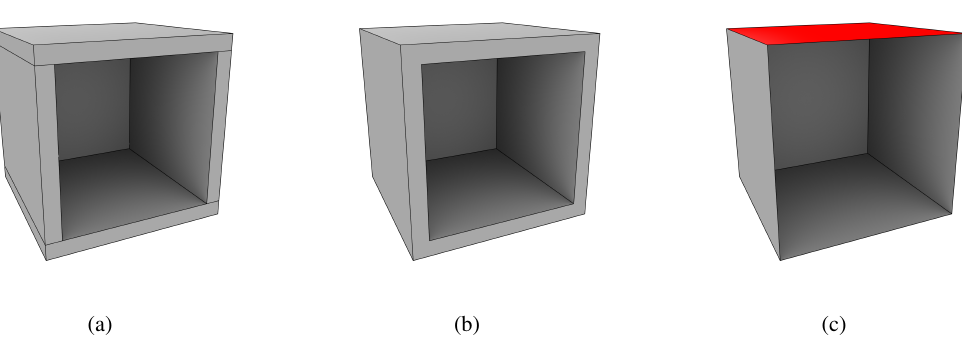
Figure 6. A method to get the semantically labelled outer surfaces of (a) a simple IFC model in a manner suitable for CityGML LOD3 could involve (b) computing the Boolean set union of certain IFC entities (e.g. IfcSlabs) and (c) extracting the outer envelope and classifying surfaces using their normals (Boeters et al., 2015; Donkers et al., 2016).